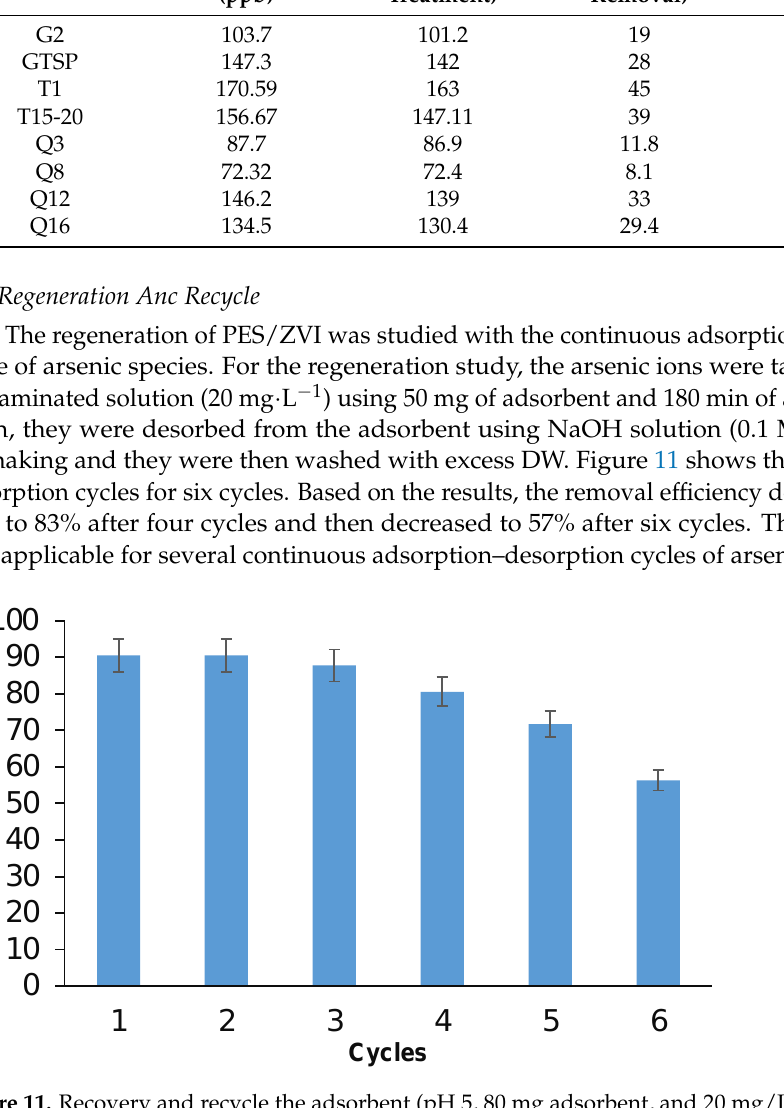
Figure 11. Recovery and recycle the adsorbent (pH 5, 80 mg adsorbent, and 20 mg/L arsenic).